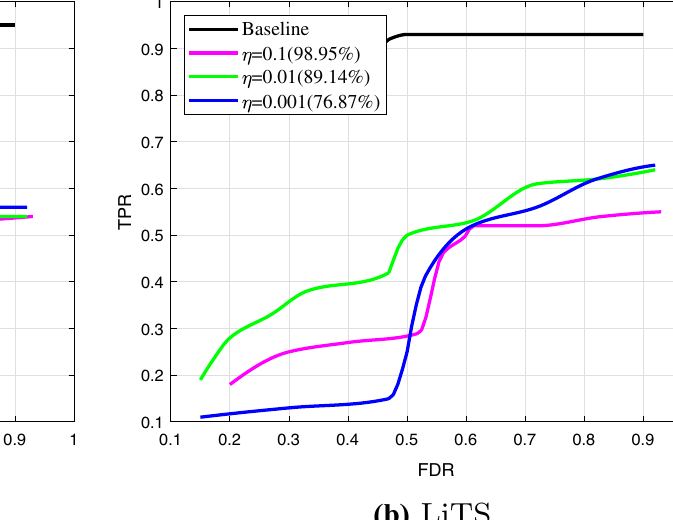
Fig. 2 ROC curves of voxel-level performance on the retained pre- dictions for different uncertainty thresholds. Percentage in the brackets shows ratio of voxels retained at that particular thresh-